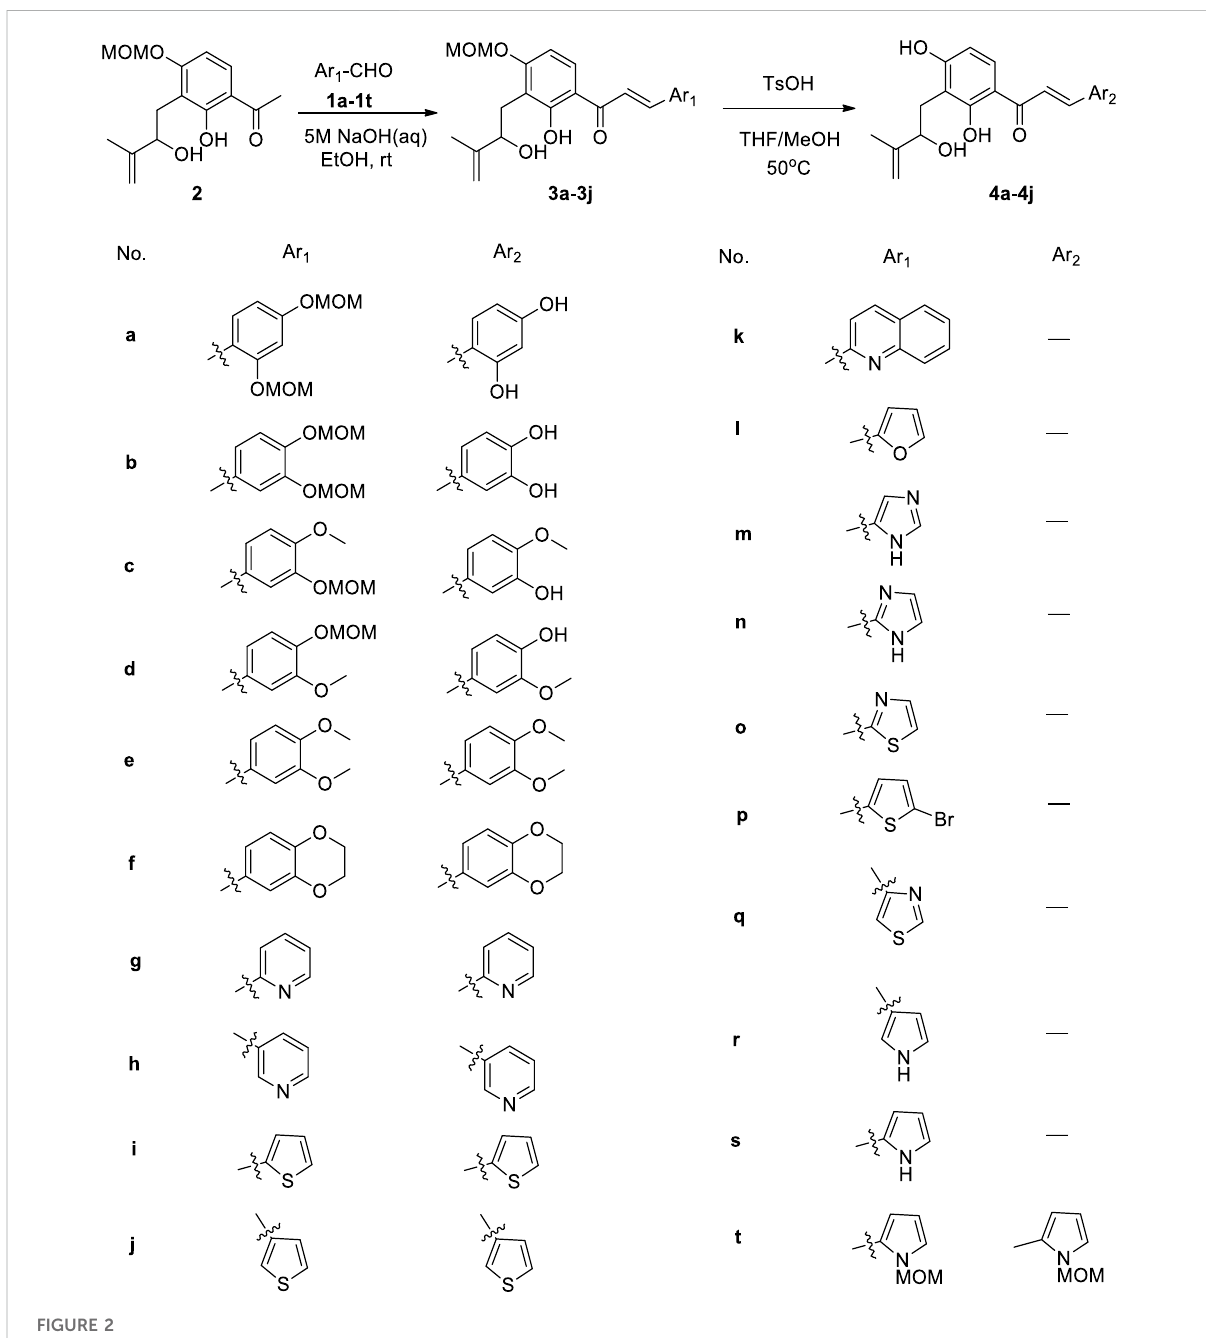
Synthesis of new chalcone derivatives 4a – 4j